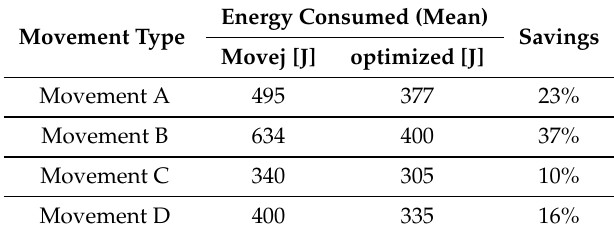
Figure 9. Joint currents for movement A : the optimized trajectory (including control points of Bezier curves) and trajectory obtained by execution of default movej command on UR3. Table 2. Table of energy consumption for given